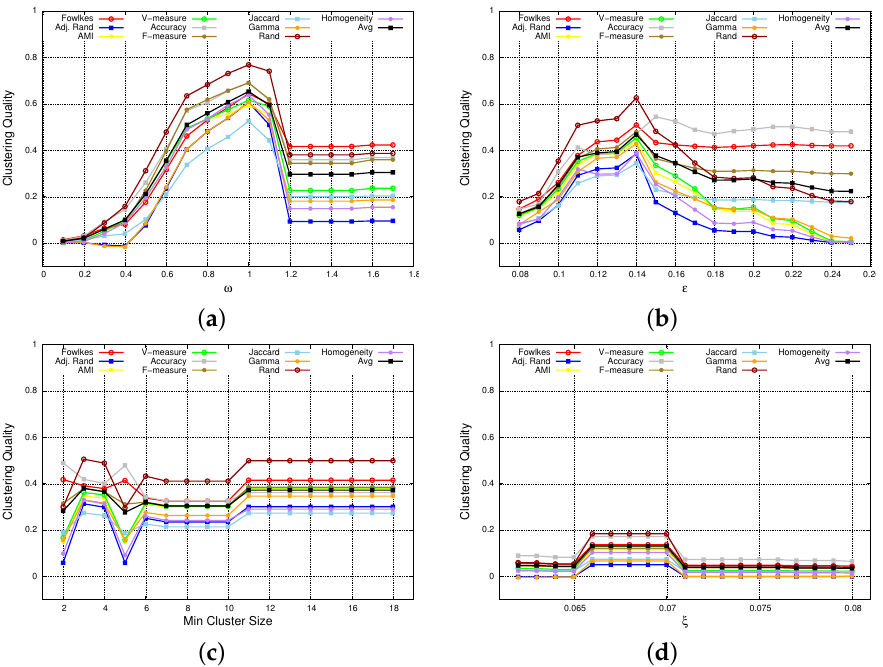
Figure 4. The Chess dataset: clustering quality indices vs. different input parameter values. ( a ) CHD. ( b ) DBSCAN. ( c ) HDBSCAN. ( d ) OPTICS-Xi.